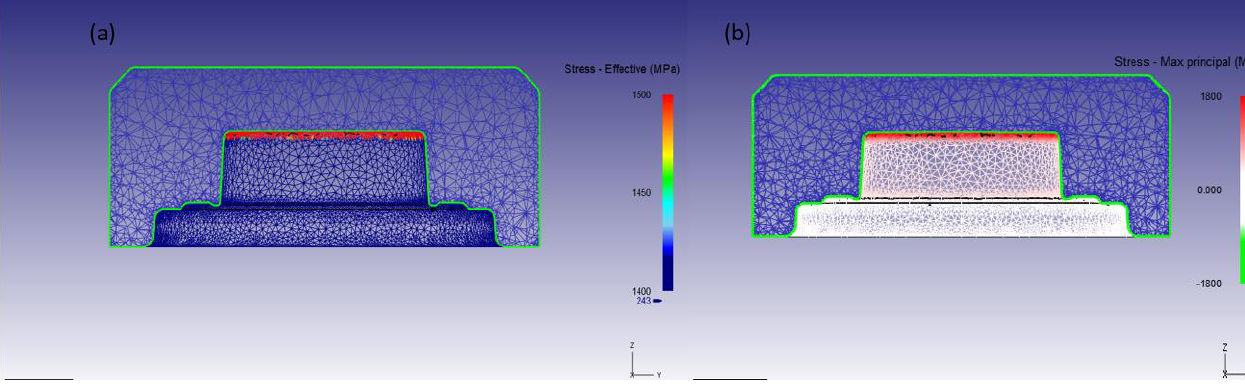
Figure 11. A cross-section depicting the stress distribution at maximum load: ( a ) Effective stress, ( b ) Maximum principal stress.